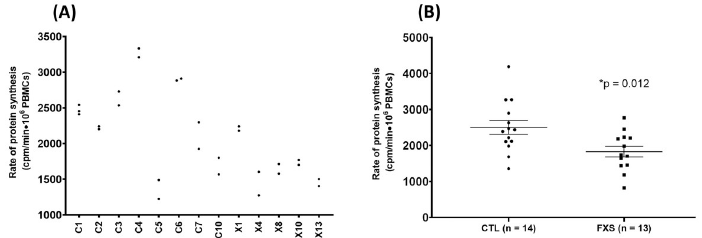
Fig 3. A decreased rate of protein synthesis is observed in fragile X PBMCs. (A) Intraindividual variability of the protein synthesis rate measurements. Each dot indicates a single experiment. (B) PBMCs rates of protein synthesis measurement obtained from 14 controls males and 13 FX males. A 26.9% decrease is observed (mean ± SEM) in the FX group (1830 ± 150 CPM/min) when compare to the control group (2500 ± 194 CPM/min). Error bars represent the SEM. Unpaired